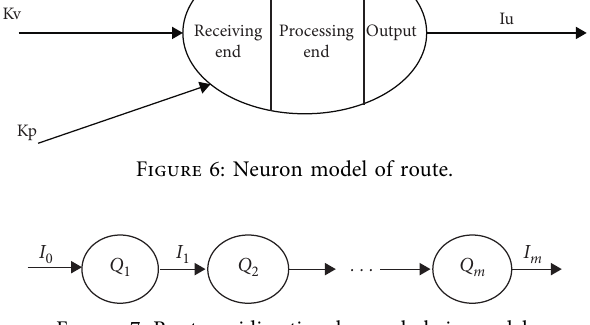
Figure 5: MP neuron model.